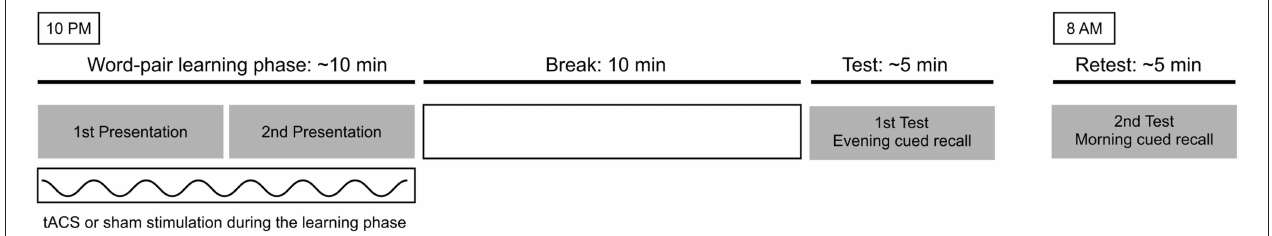
FIGURE 1 | The experimental procedure. At 10 p.m., during 10min of active or sham tACS stimulation the participants saw a word list two times. After an unfilled break of 10min the subjects were tested on cued recall of the second word. Next morning at 8 a.m. they were tested again on the cued recall of the second word. The subjects participated in the study according to a repeated measures design.